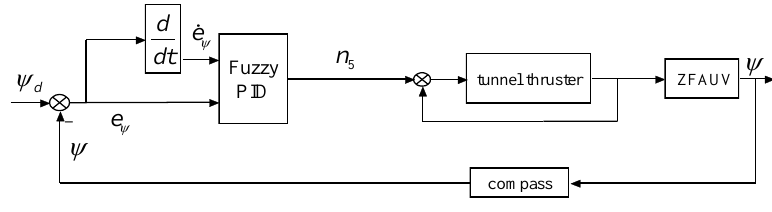
Figure 10. Heading controller.